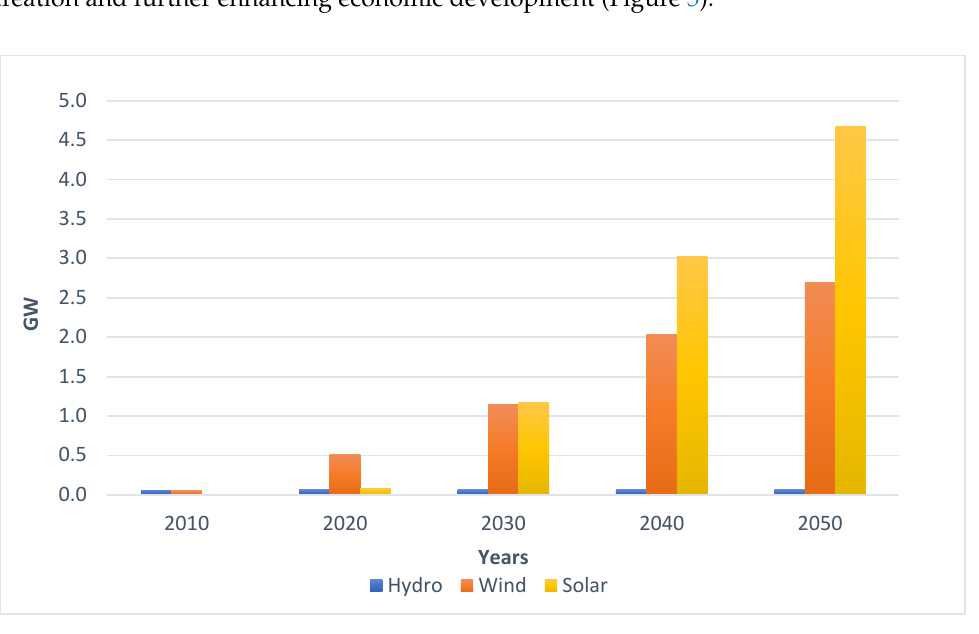
Figure 6. Tunisia’s C O 2 energy-related emissions by sector (Mt CO2), over 2010 – 2050 ( Left : Uncon- ditional scenario, Right : Conditional scenario), Source: MENA-EDS Model (Unconditional and Con- ditional NDC Scenarios).